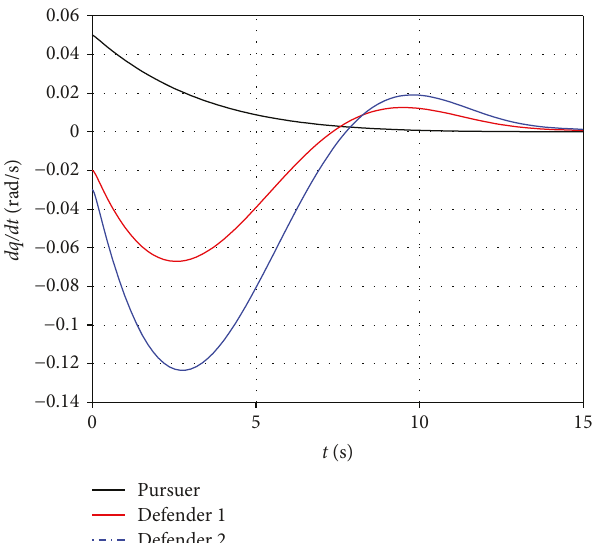
Figure 7: The acceleration variation of Defender 1.